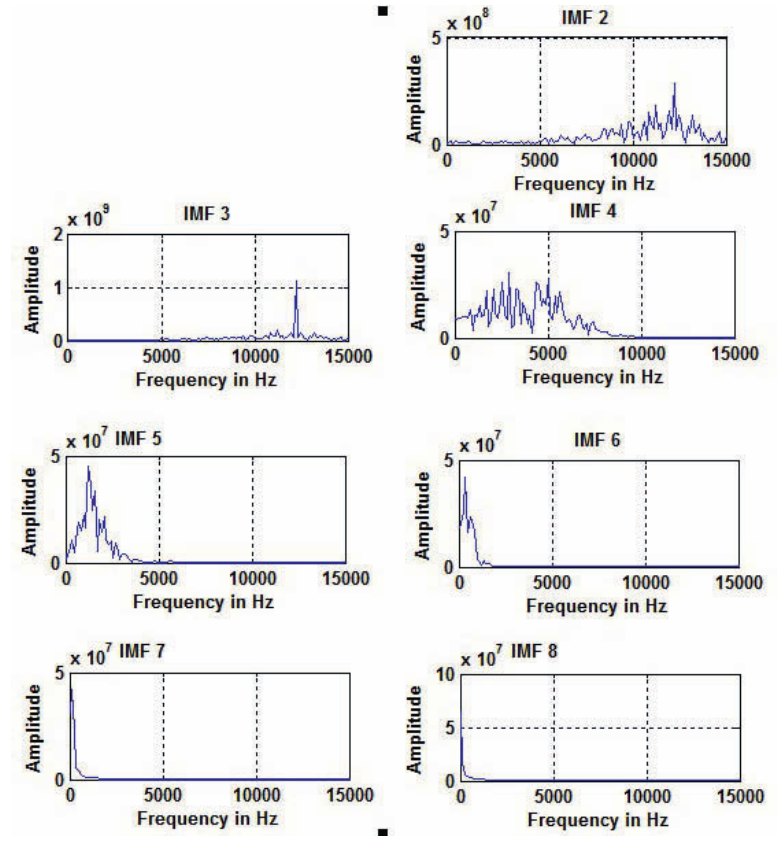
Figure 9. FFT of